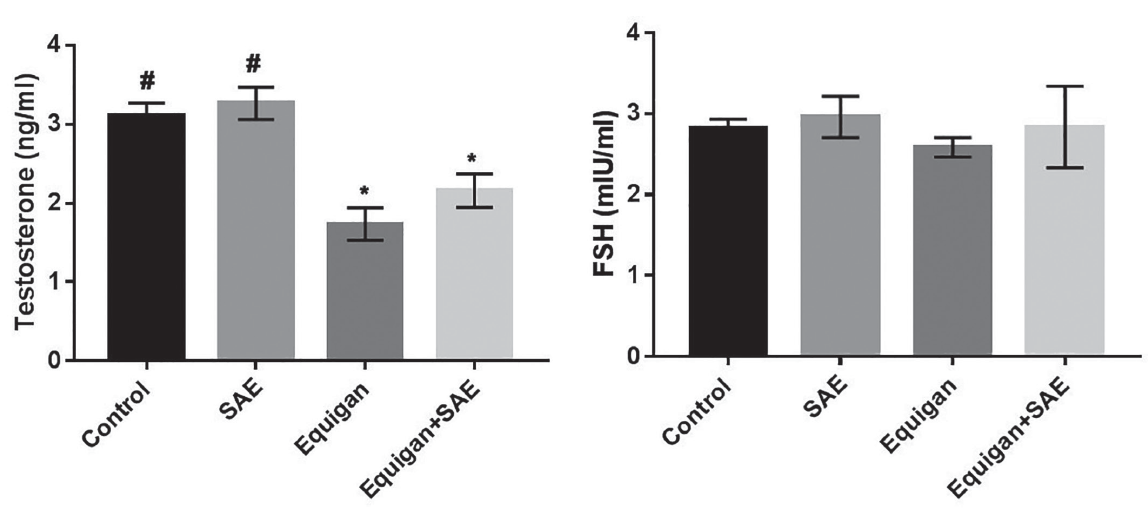
difference from the control group at * p < 0.05; Significant difference from Equigan group at # p < 0.05).